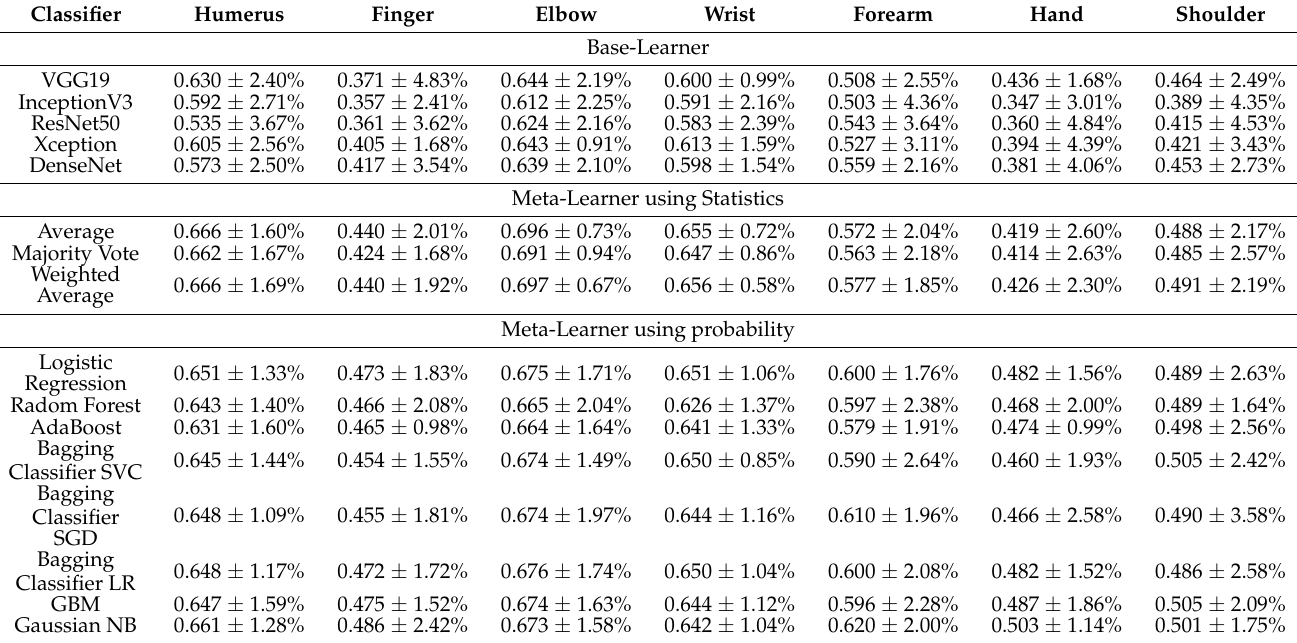
Table 1. The average Kappa score achieved by each classifier for every organ ( ± Confidence Interval 95%). Test performance is